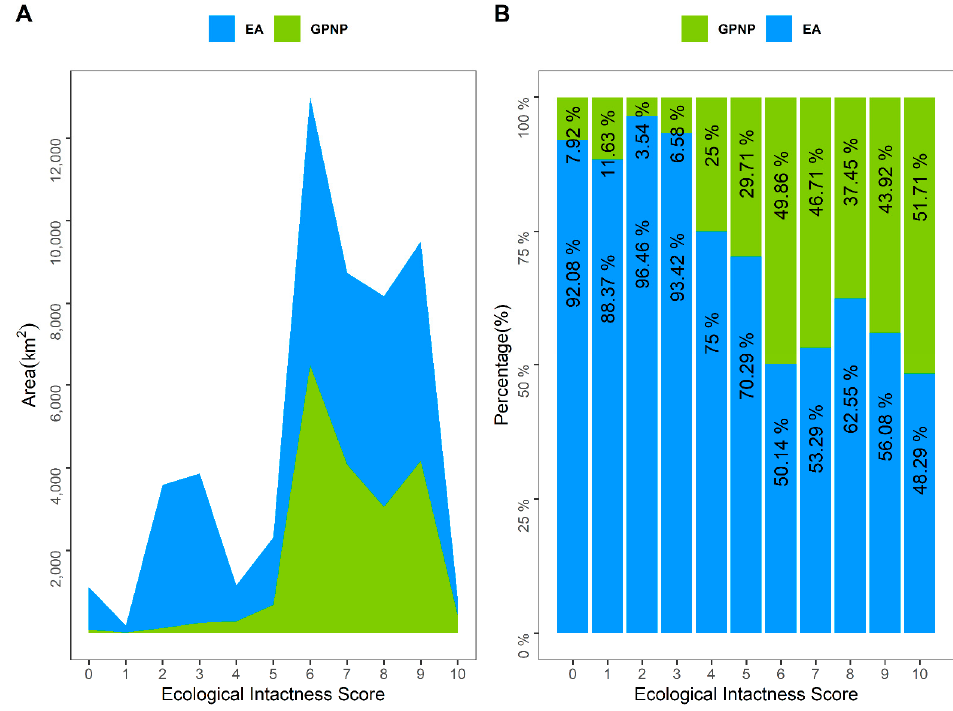
Figure 4. The area ( A ) and area proportion ( B ) of different ecological intactness scores within GPNP and exterior areas (EA) in the study area. Within GPNP, the EIS in the east of Qionglaishan and south of Minshan was rela- tively lower than in other regions. Additionally, the ecological intactness scores in the north of Qionglaishan, south of Daxiangling, and middle of Minshan were relatively high (Figure 3). Comparing the EIS levels of different altitude ranges, the mean EIS at elevations less than 1200 m was 6.0. The mean EIS values from 1200 m to 4000 m were between 6.5 and 7.5, and the EIS above 4000 m mean scores exceeded 7.5. Mean intactness scores below 1200 m in the GPNP were significantly higher than scores at the same altitudinal range in exterior areas (Figure 5A).